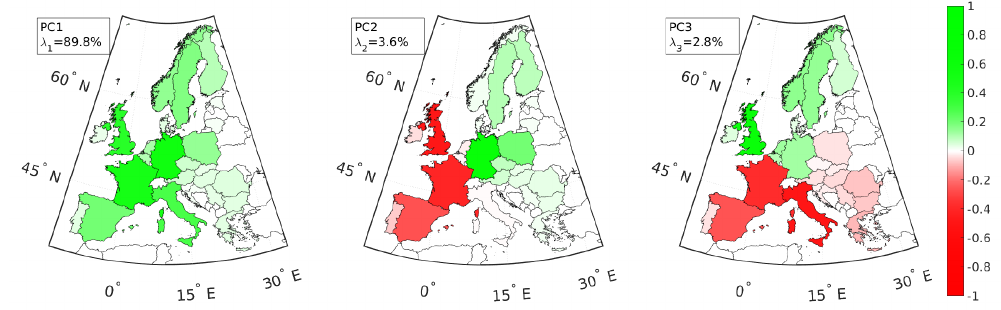
Figure 4. The three principal mismatch components for α = 0.